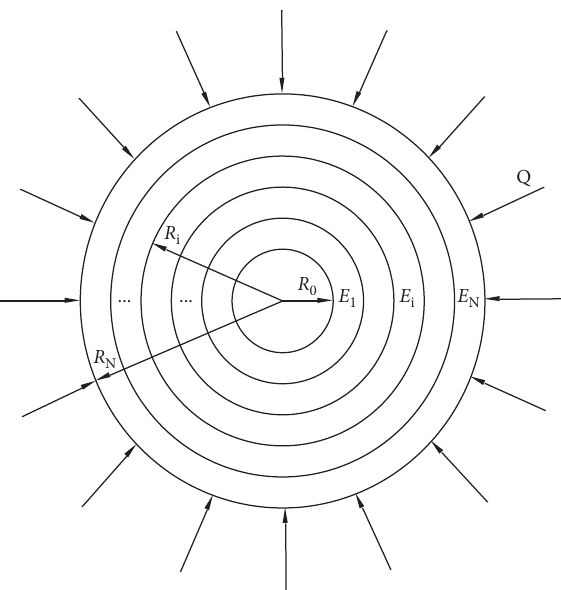
Figure 2: Calculation model of N-layer